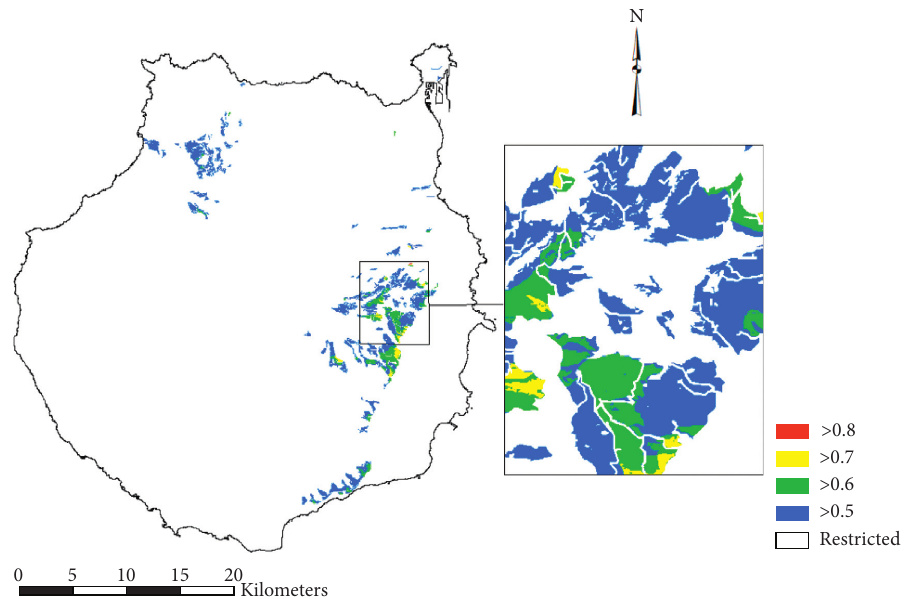
Figure 16: Sensitivity analysis map (minimum score for priority site).